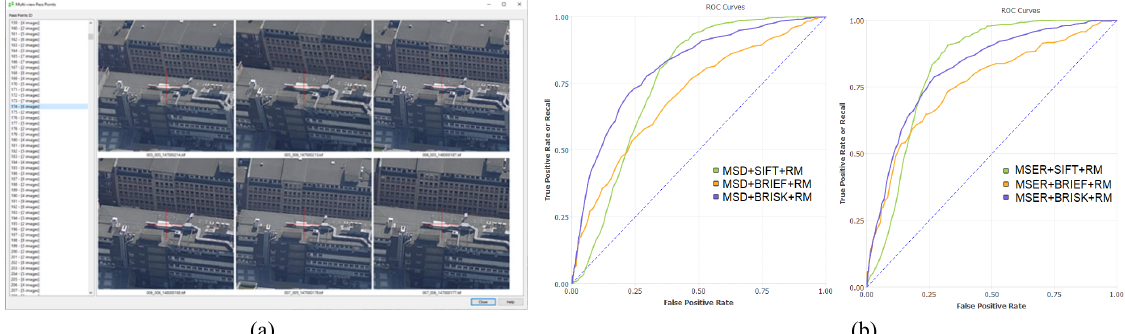
Figure 4: Multi-view visualization of the matching results (a) and ROC curves for the results presented in the Table 1 (b).